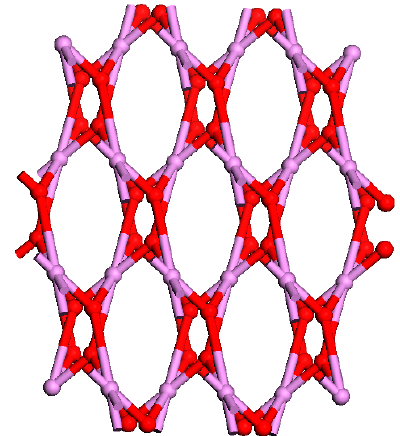
Figure 3. Schematic representation of the (3,6)-connected net of compound 1 .